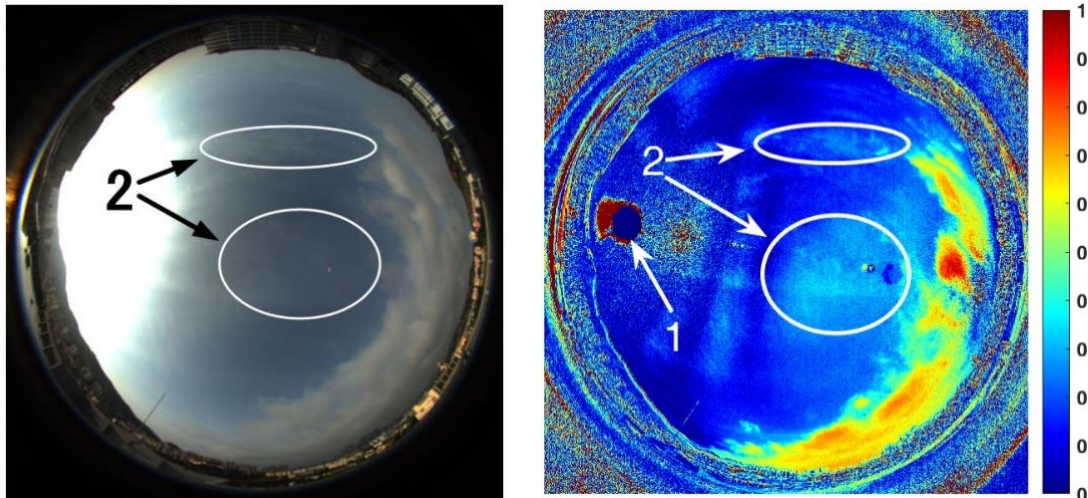
Figure 8. Color image of the sky cloud distribution and the corresponding NPDDI distribution results. The optical thickness of clouds can be distinguished by different NPDDI values, reflected in the NPDDI distribution image as the corresponding color in the color bar.